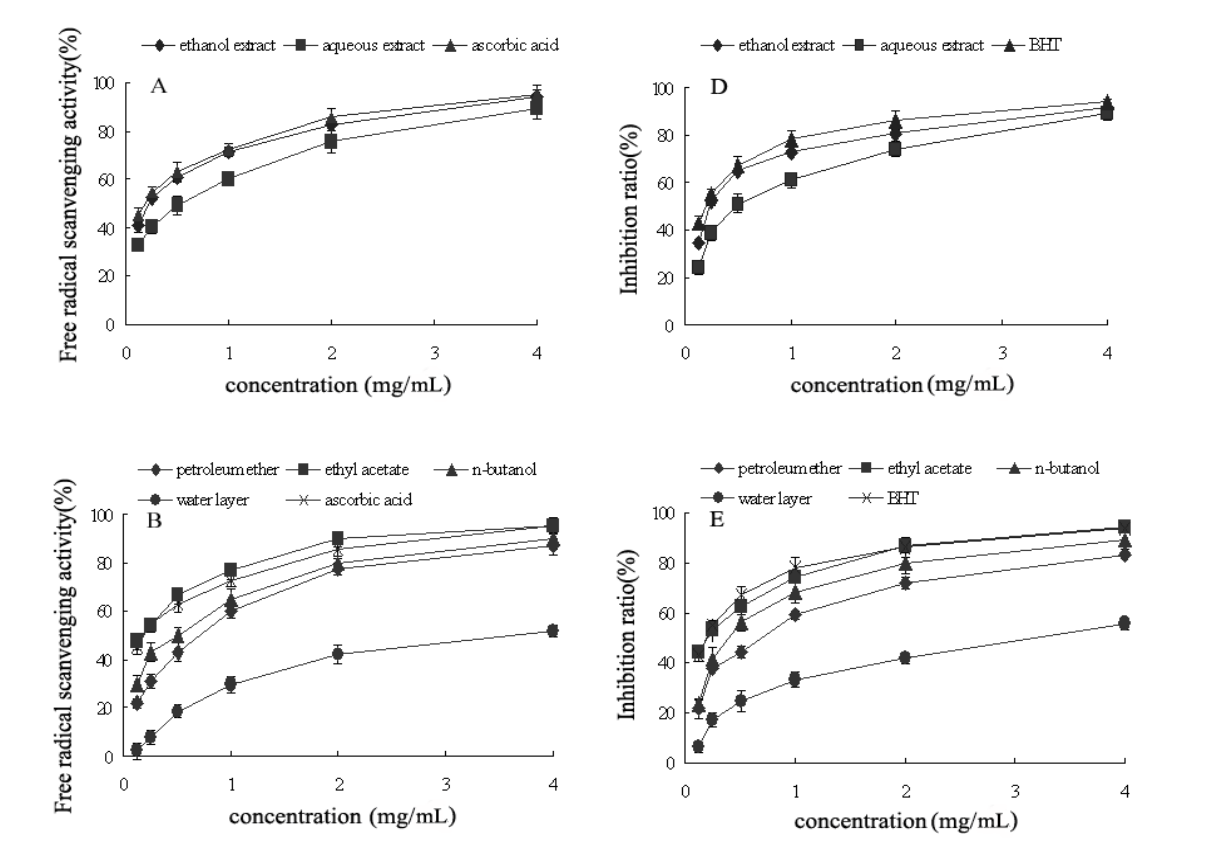
Figure 2. Antioxidant activities of extracts, four fractions and four main components (cajaninstilbene acid, pinostrobin, vitexin and orientin) in pigeonpea leaves (A-C: DPPH radical scavenging assay; D-F: β -carotene-linoleic acid test). Values of each curve are means ± SD (n = 3). P <